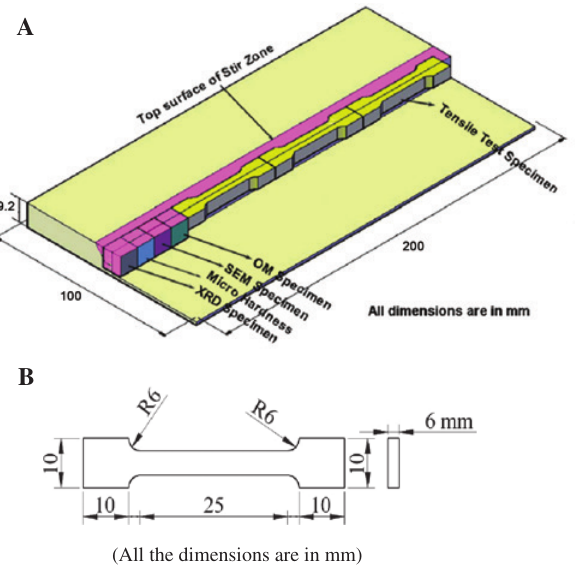
Figure 1: Specimen preparation details.